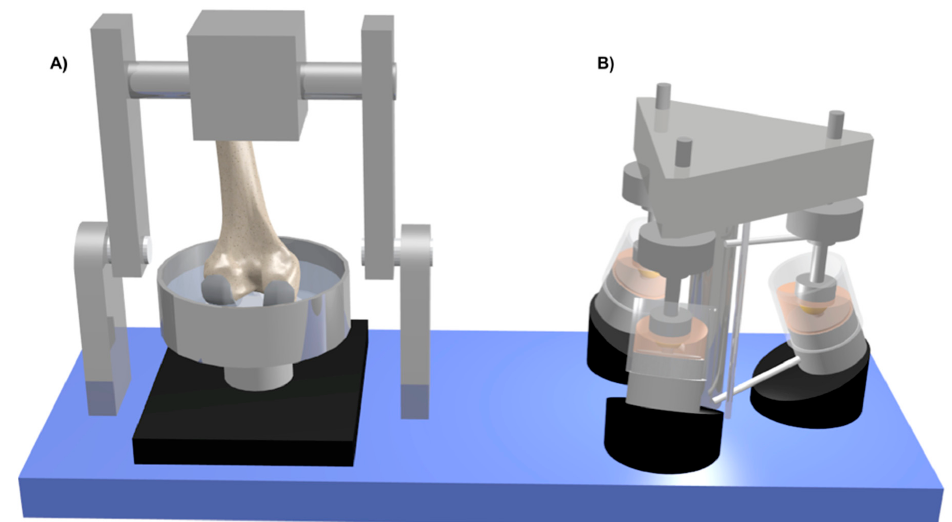
Figure 2. Schematic representation of the pin on disk tests. In particular, the pin is pressed against a rotating disk under the given load. The pin can be of any shape; however, the most popular shapes are spherical or cylindrical.